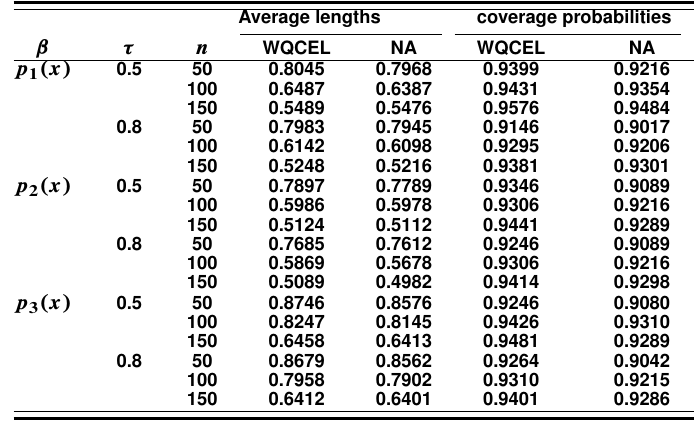
Table 5. The average lengths and empirical coverage probabilities of the confidence intervals for (cid:18) with different forms of the selection probability function p.x/ , the sample sizes n and the quantile level (cid:28) under nominal level 0.95.